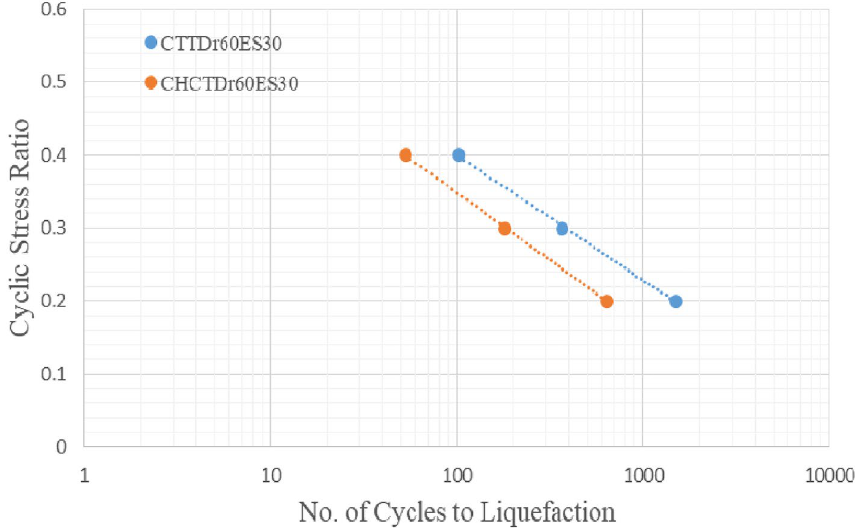
Figure 20. Stress ratio vs number of cycles to liquefaction for samples (Dr 60% FC0ES30) in CTT and CHCT.